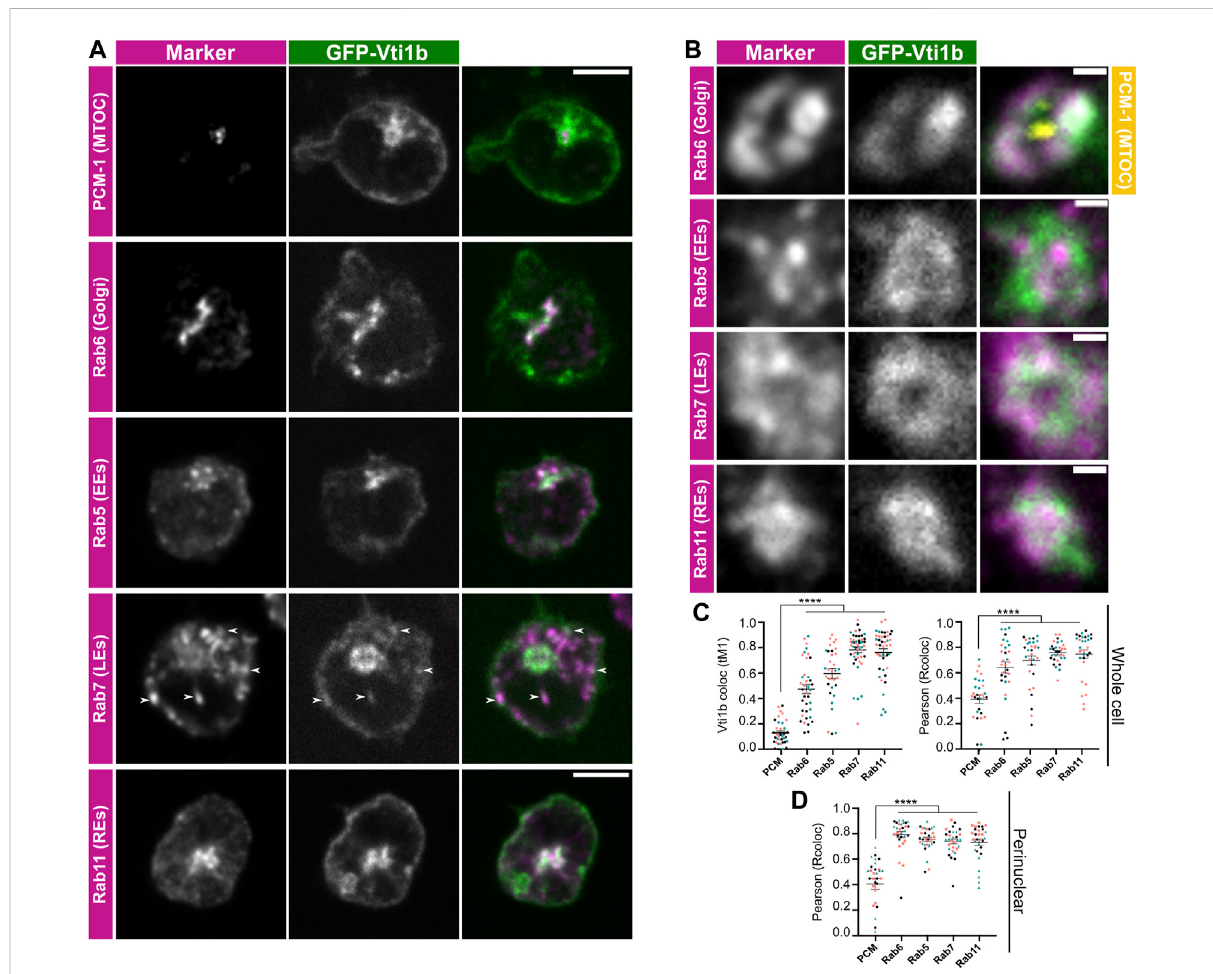
FIGURE 1 Vti1bislocalisedtotheGolgicomplexandendosomesinBcells. (A,B) A20D1.3 BcellsweretransfectedwithGFP-Vti1b(ingreen)andsubjected to immuno fl uorescence analysis (in magenta) with anti-PCM-1 (MTOC), Rab6 (Golgi), Rab5 (early endosomes; EEs), Rab7 (late endosomes/ lysosomes; LEs), and Rab11 (recycling endosomes; REs) antibodies. The samples were imaged with a spinning disk confocal microscope. Single representative slices are shown. Scale bar: 5 µm. (B) Representative zoom-in images of the perinuclear region are shown with PCM-1 is shown in yellow. Scale bar: 500 nm. (C,D) Colocalisation analysis of Vti1b with the different markers in the (C) whole cell as shown in (A) or (D) the perinuclear compartment as shown in (B) . Representative results of n = 3 independent experiments. Results are shown as mean ± SEM; every dot represents a cell and the colours represent the 3 experiments. Statistics: unpaired t